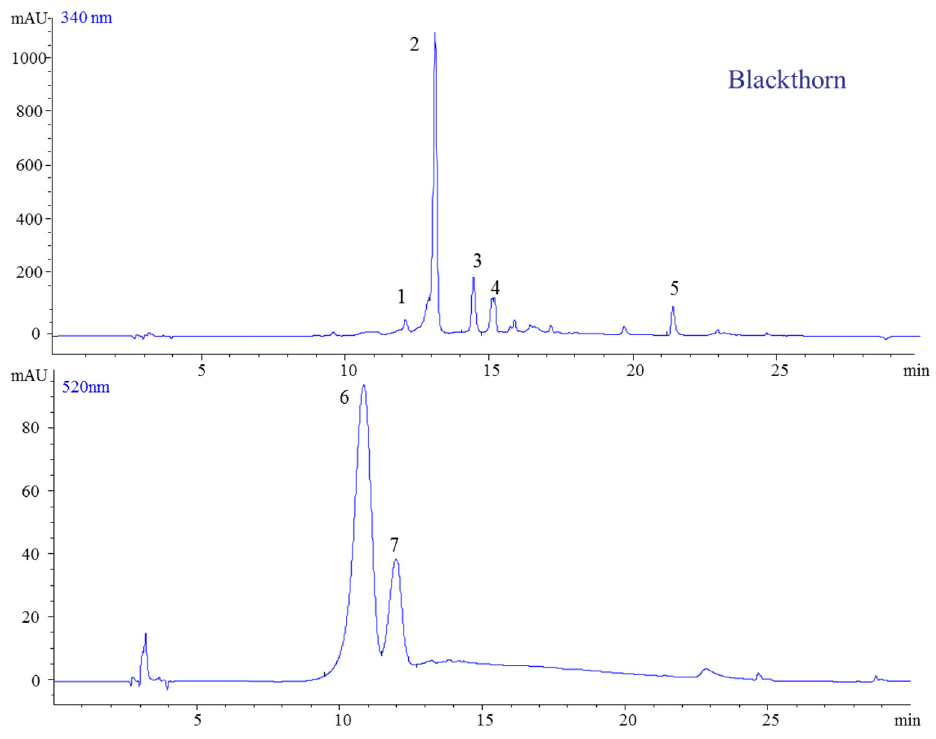
Figure 4. HPLC-DAD chromatogram of extracts from blackthorn jams (at 340 and 520 nm).